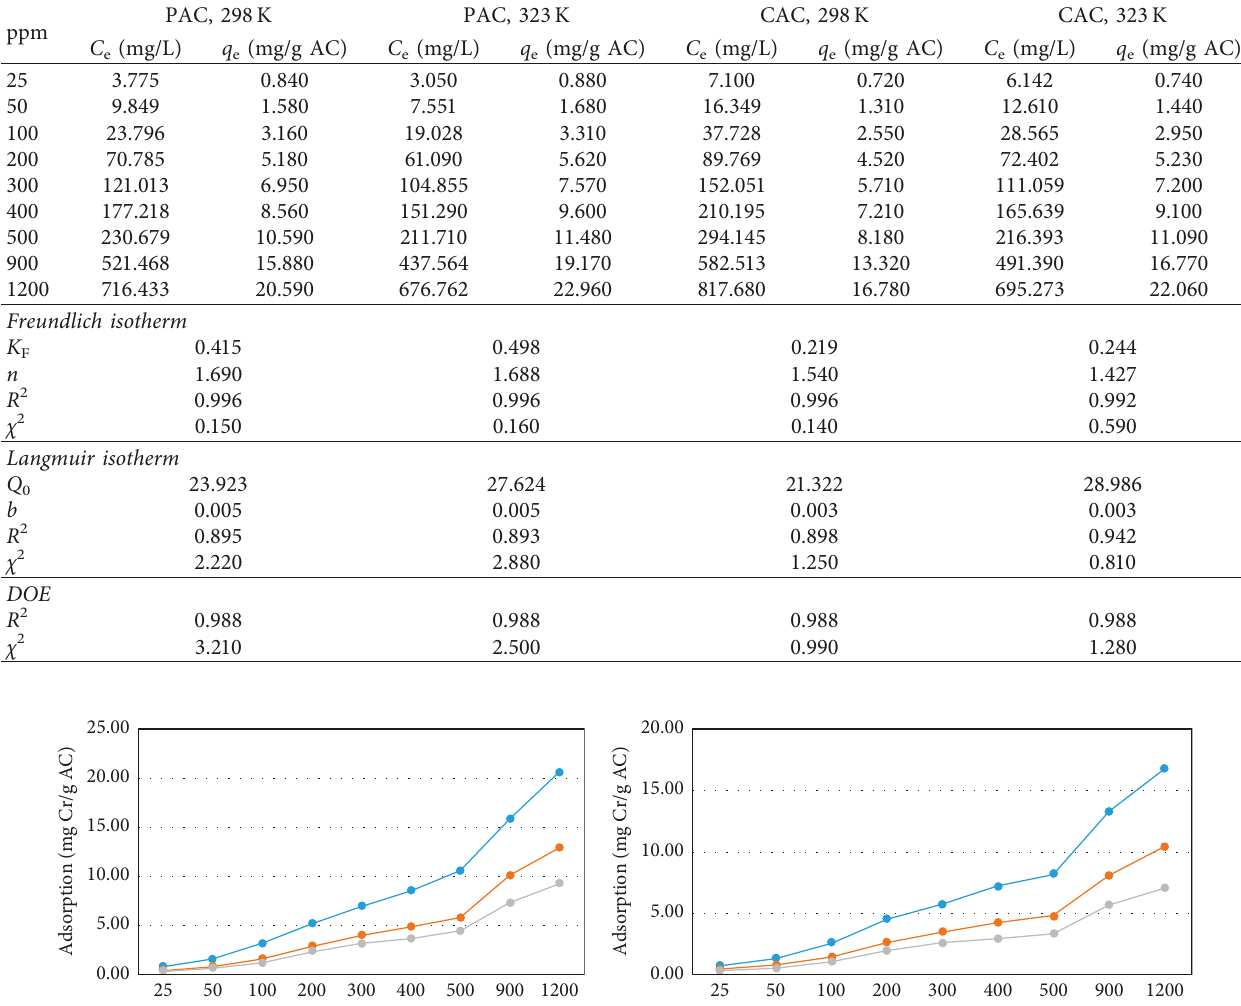
Table 5: Freundlich and Langmuir isotherm constants, chromium(VI) adsorption values, and model performances at different tem- peratures (pH 2). (cid:31)